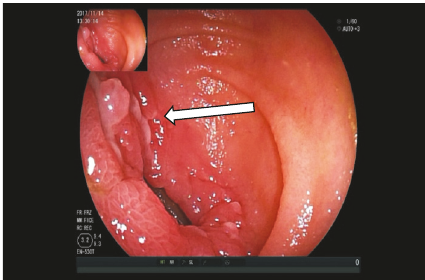
Figure 10: Enteroscopy showing a close view of the 3.0 x 2.0 cm size jejunal ulcer.